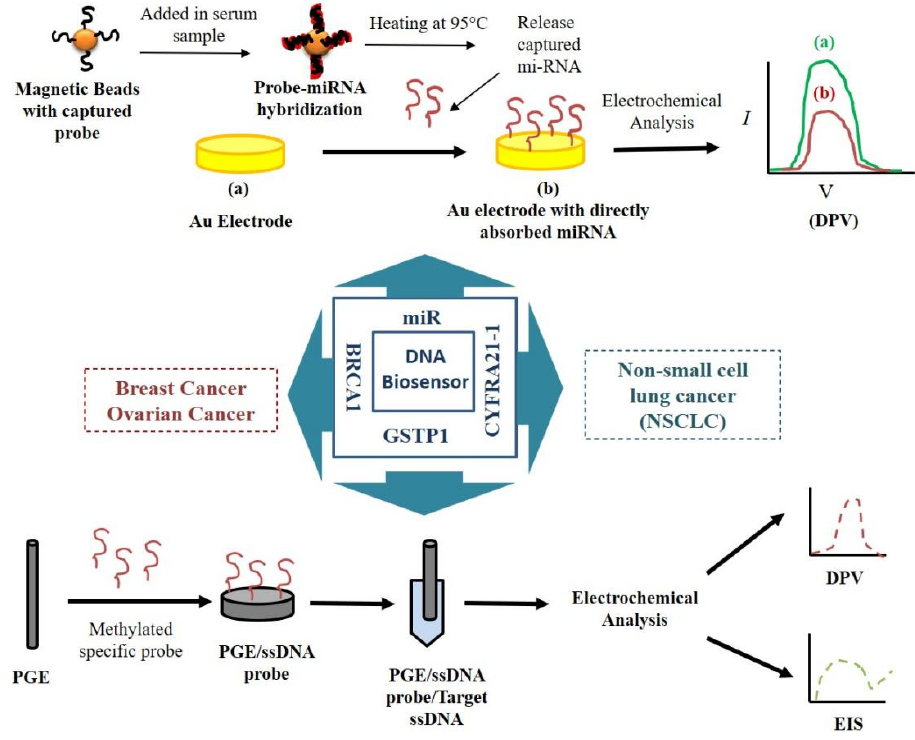
Figure 1. Schematic diagram of nucleic acid-based biosensors for detecting cancer biomarkers .